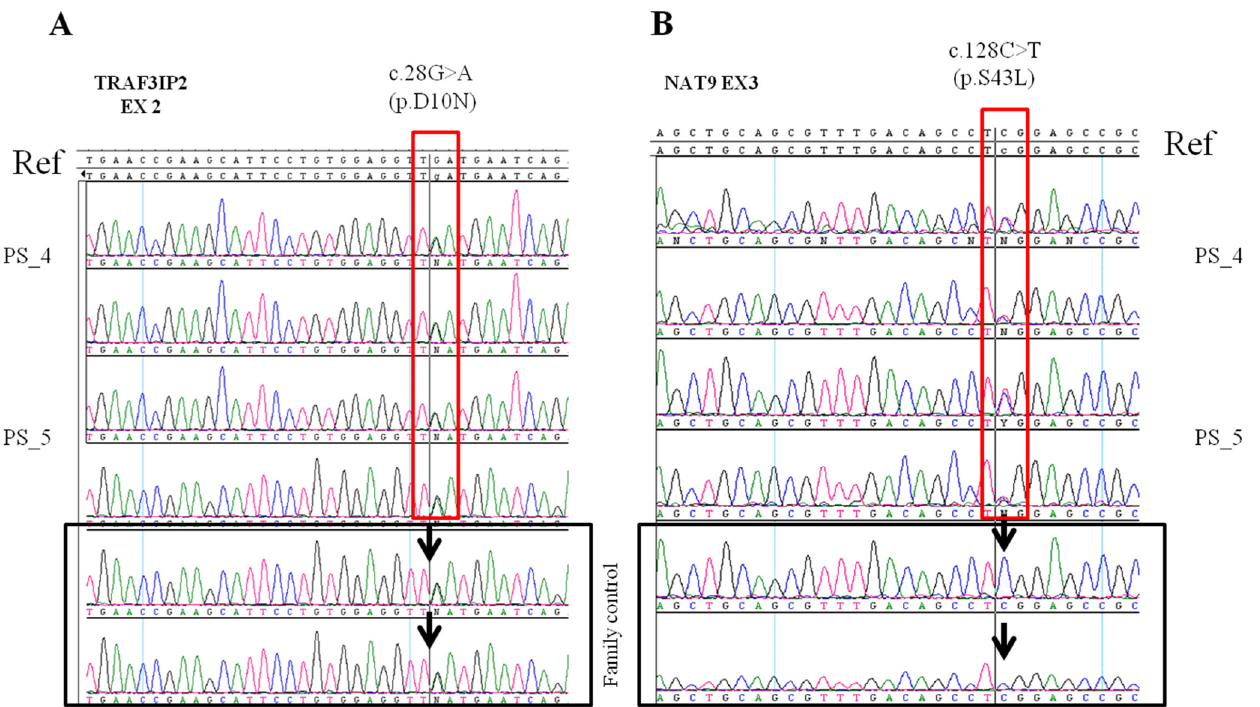
Figure 1. The electropherograms obtained by Sanger sequencing; for each patient, the forward (FW) and the reverse (RW) strands of the same sequence are represented. ( A ) The electropherograms of the variant in the TRAF3IP2 gene in PS_4, PS_5 and in the familial control. All three are carriers of the variant in heterozygosity. ( B ) The electropherograms of PS_4 and PS_5 and from the family control are shown. In this case, the variant in NAT9 is present in heterozygosity in both the mother (PS_5) and daughter (PS_4) affected by plaque-psoriasis, but not in the unaffected control (II.1) at the time of the test. Black arrows identify the presence/absence of the variant in the family negative control.